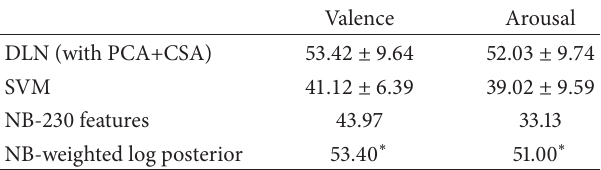
Table 3: Summary of accuracy performance